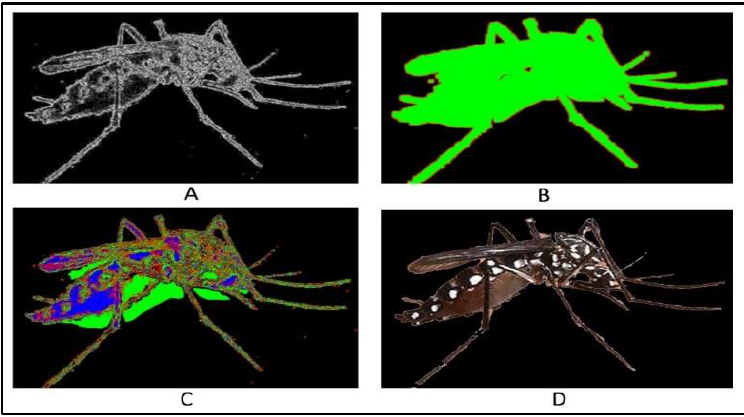
Figure 4. The edge image ( A ); the training image ( B ) (the green region represents the most probable foreground pixels and red region represents the moderate probable foreground region); the training image ( C ) after thresholding the saliency map; and the segmented region ( D ).